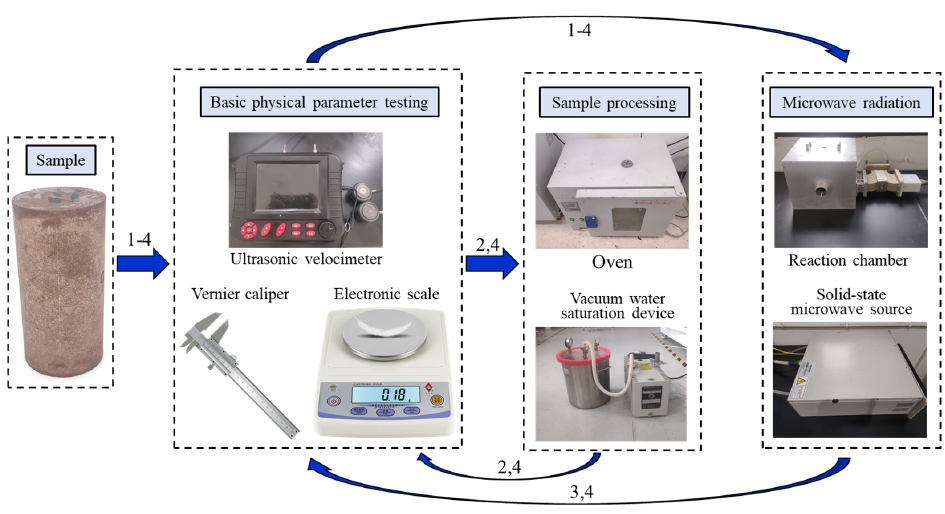
Figure 1. Microwave cycle radiation path.